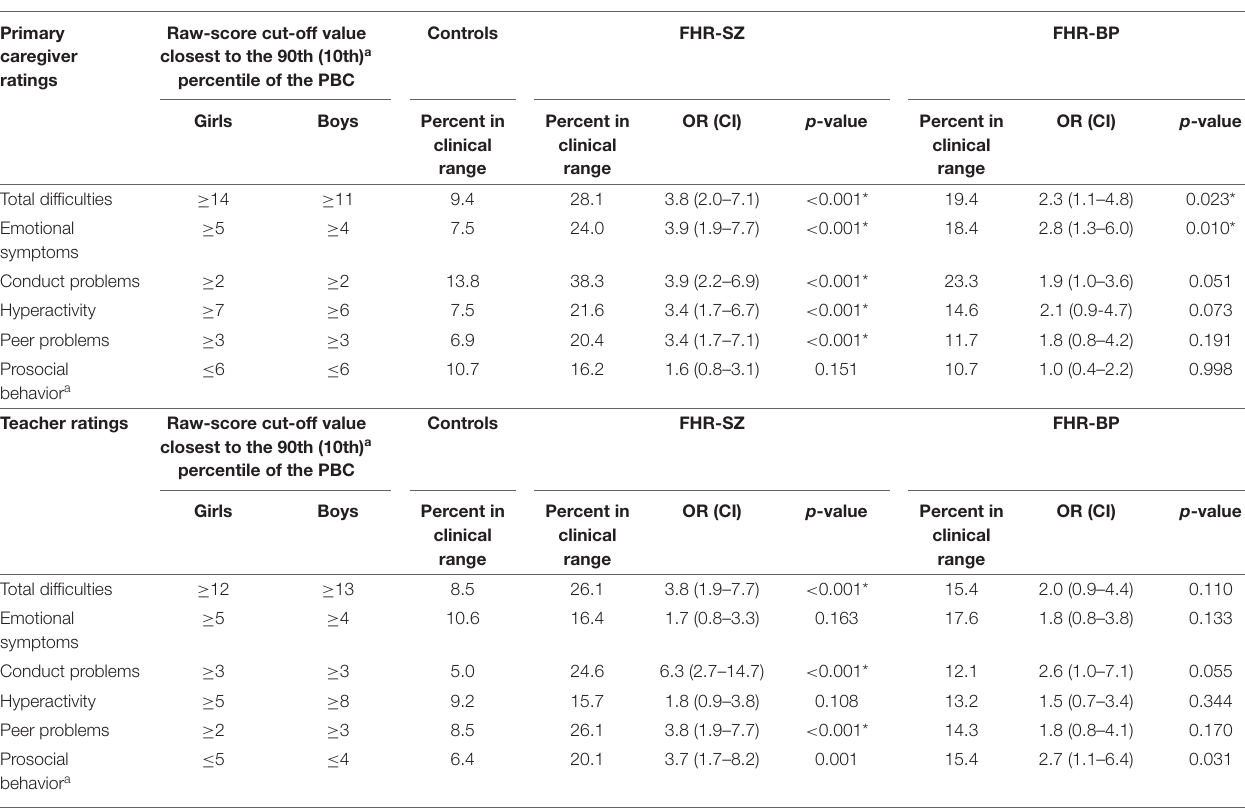
TABLE 3 | Proportion of children with familial high risk of schizophrenia or bipolar disorder scored within clinical range compared to that of controls. Primary